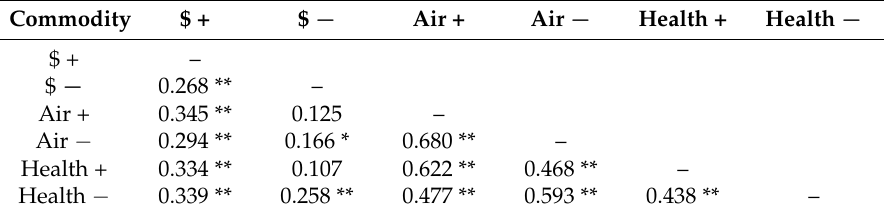
Table 3. Spearman AUC Correlation Matrix for Gains and Losses for Monetary, Air, and Health Outcomes. Commodity $ + $ − Air + Air − Health + Health − $ + – $ − 0.268 ** 0.345 ** 0.125 0.294 ** 0.166